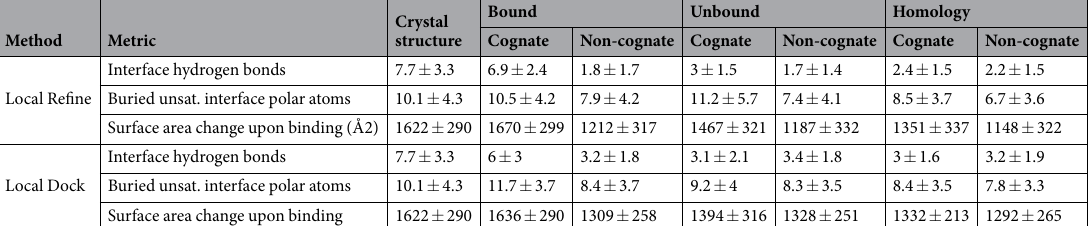
Table 2. Interface metrics for cognate and non-cognate models generated using local refine and local